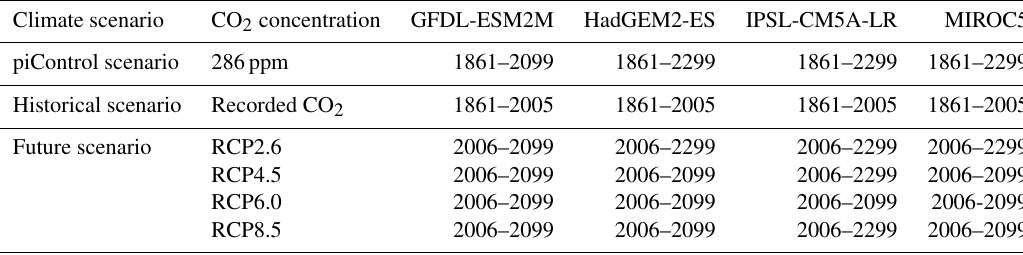
Figure 1. Location of the Cuntan hydrological station, GCM grids, meteorological stations, and spatial distribution of the land use and soil types in the upper Yangtze River basin. We created the map with ArcGIS ourselves, the vector data of soil types were taken from the Institute of Soil Science, Chinese Academy of Sciences (CAS), and the land use map was downloaded from the Resource and Environment Data Cloud Platform (http://www.resdc.cn/, last access: November 2018). Table 1. Availability of climate scenarios from four GCMs for different